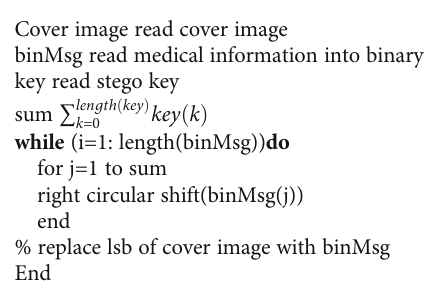
Algorithm 1: Embedding stage algorithm.